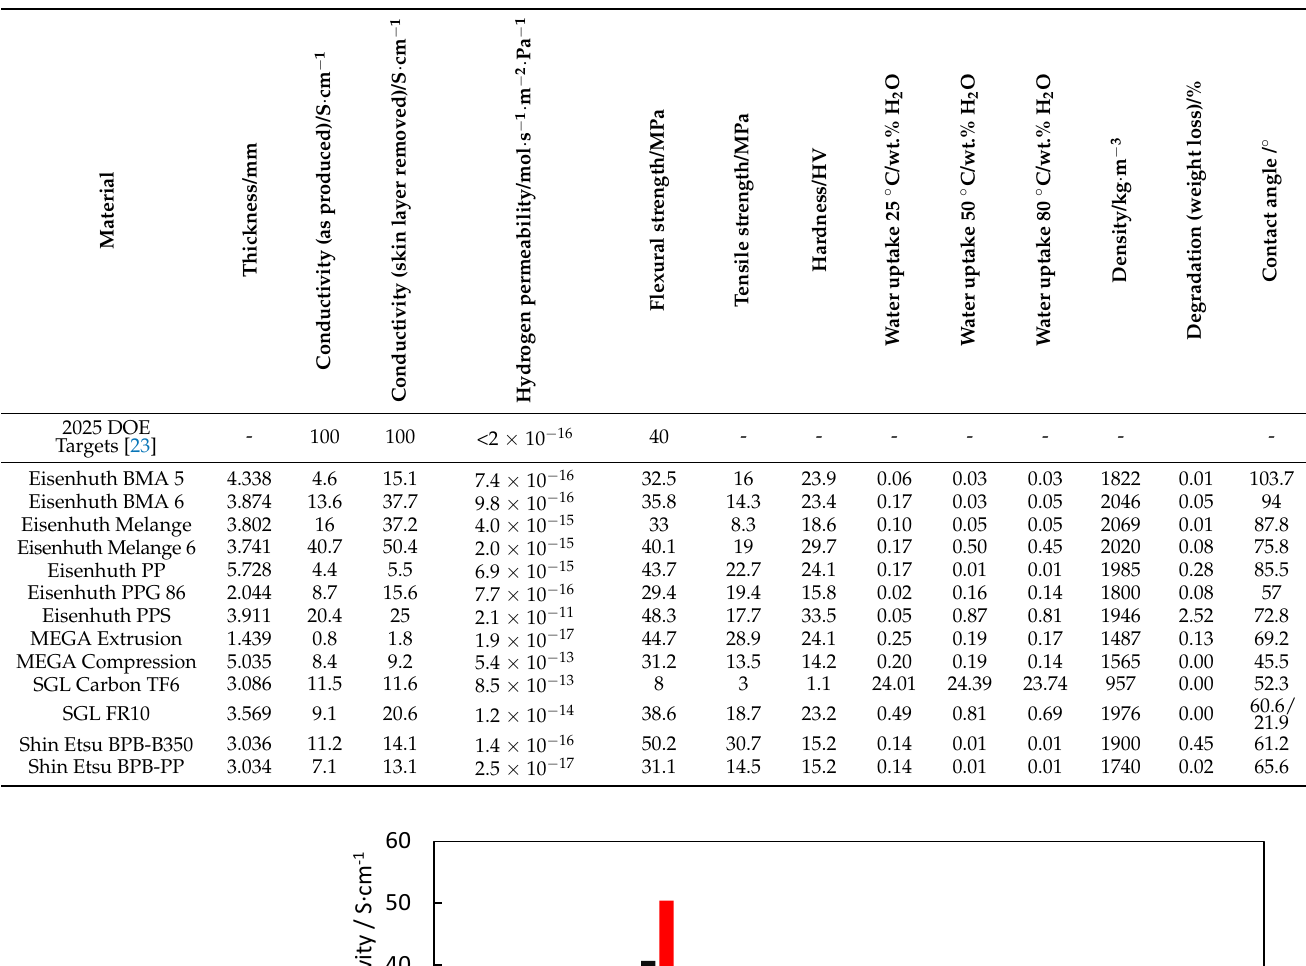
Table 3. General overview of the individual bipolar plates’ parameters determined.